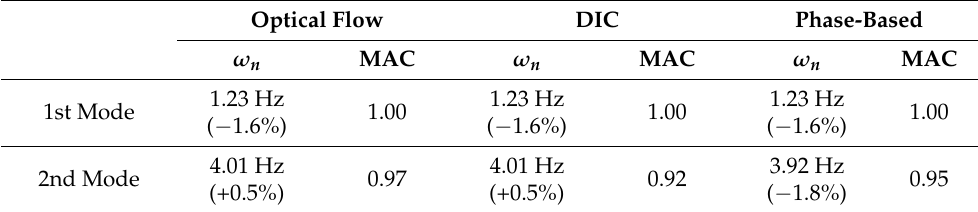
Table 4. Comparison of modal properties using the proposed three approaches. Optical